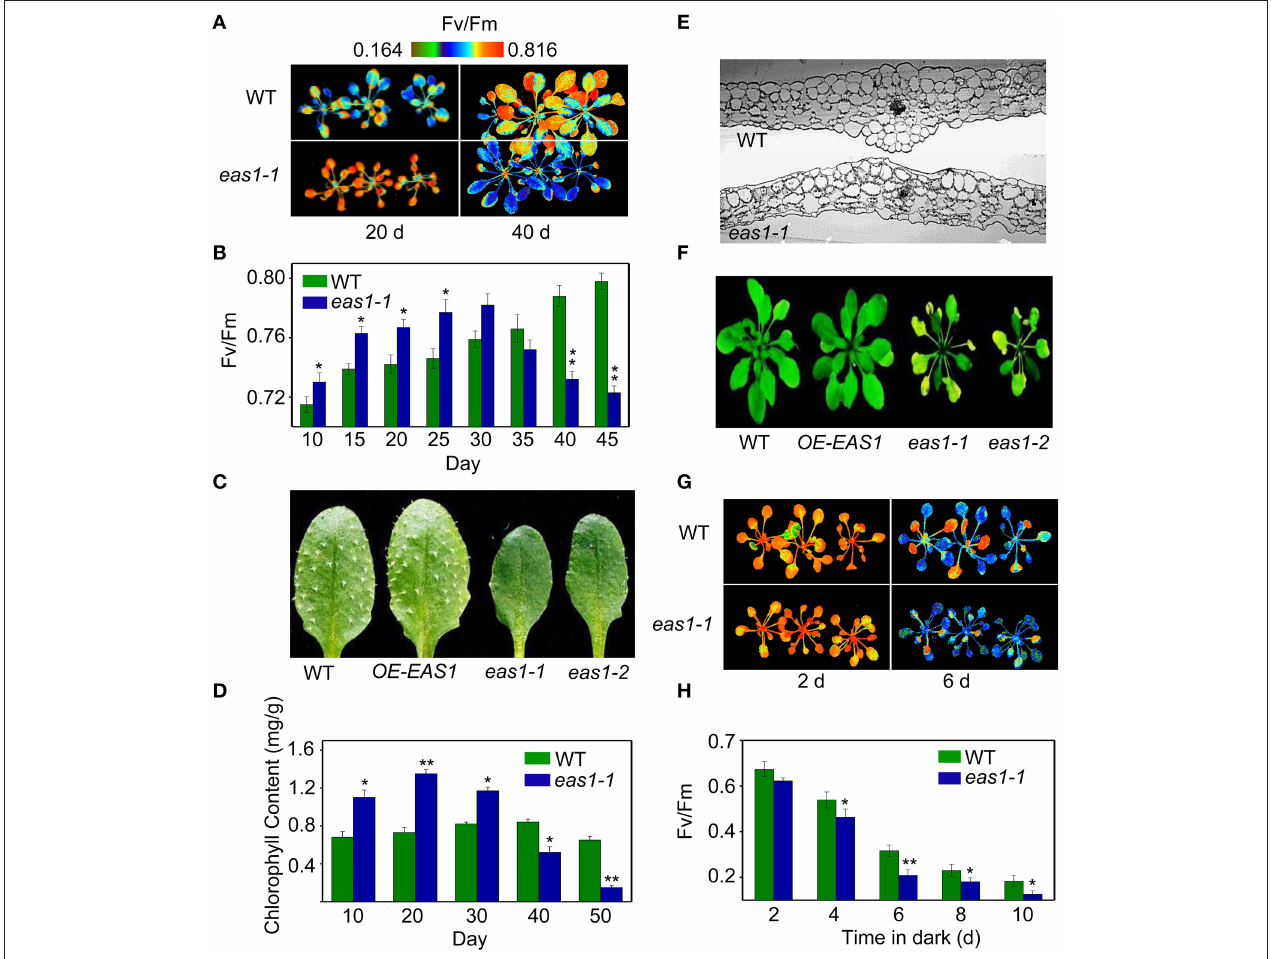
FIGURE 1 | The eas1 mutation accelerates leaf senescence in Arabidopsis thaliana . (A) Images of Fv/Fm of wild-type and eas1-1 mutant leaves on the 20th and 40th day under unstressed conditions in soil. (B) Fv/Fm values depend on different growth stages in wild-type and eas1-1 mutant plants. (C) Twenty-five-days-old leaves of wild-type and eas1-1 mutant plants. The sixth rosette leaves are shown. (D) Determination of chlorophyll contents of wild-type and eas1-1 mutant leaves at different stages of plant growth. (E) Twenty-five-days-old leaf cross-section anatomy of wild-type and eas1-1 mutant plants. (F) Thirty-five-days-old natural aging of the leaf rosettes of wild-type, overexpression of EAS1 (OE-EAS1), and eas1 mutant plants grown under unstressed conditions in soil. The flowers and stems of eas1 plants were removed. (G) Images of Fv/Fm of 20-days-old wild-type and eas1-1 mutant leaves under dark treatment for 2 and 6 days. (H) Time-dependence of Fv/Fm values in wild-type and eas1-1 mutant plants in dark treatment. Three experiments were performed with similar results. Error bars indicate standard deviations, while asterisks indicate significant differences from wild-type plants under Student’s test ( * p < 0.05 , ** p < 0.01